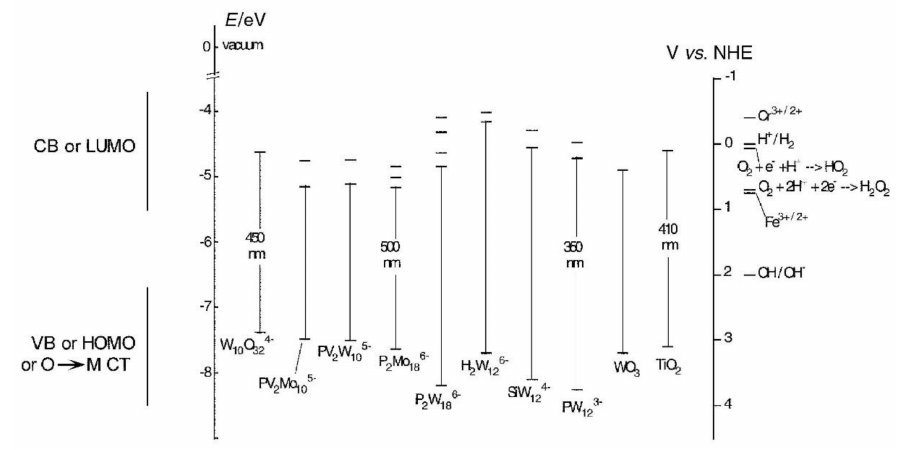
Figure 2. HOMO and LUMO of POMs